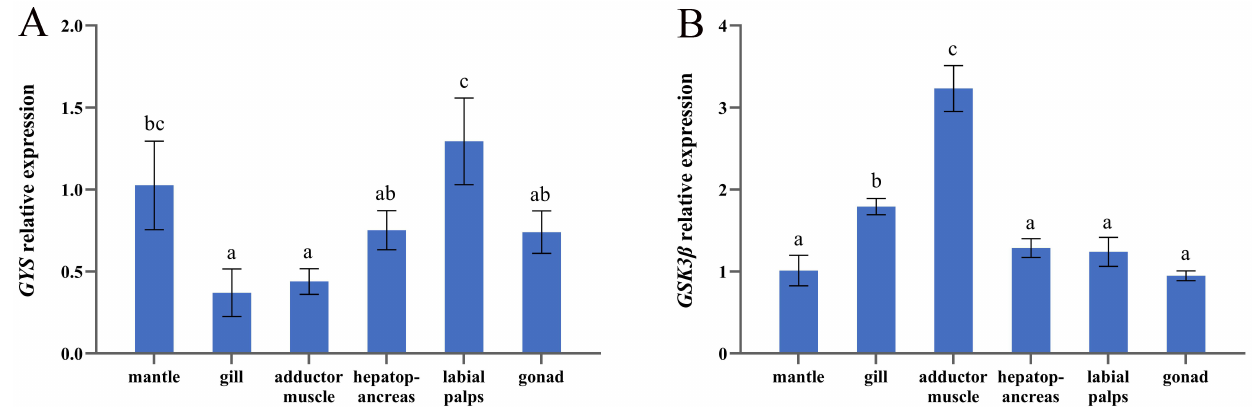
Figure 4. Relative expression levels of GYS ( A ) and GSK3 β ( B ) in mantle, gill, adductor muscle, hepatopancreas, labial palp and gonad. Bar values represent the mean of GYS or GSK3 β relative expression in three oysters, each point replicated three times. Error bars represent standard error of